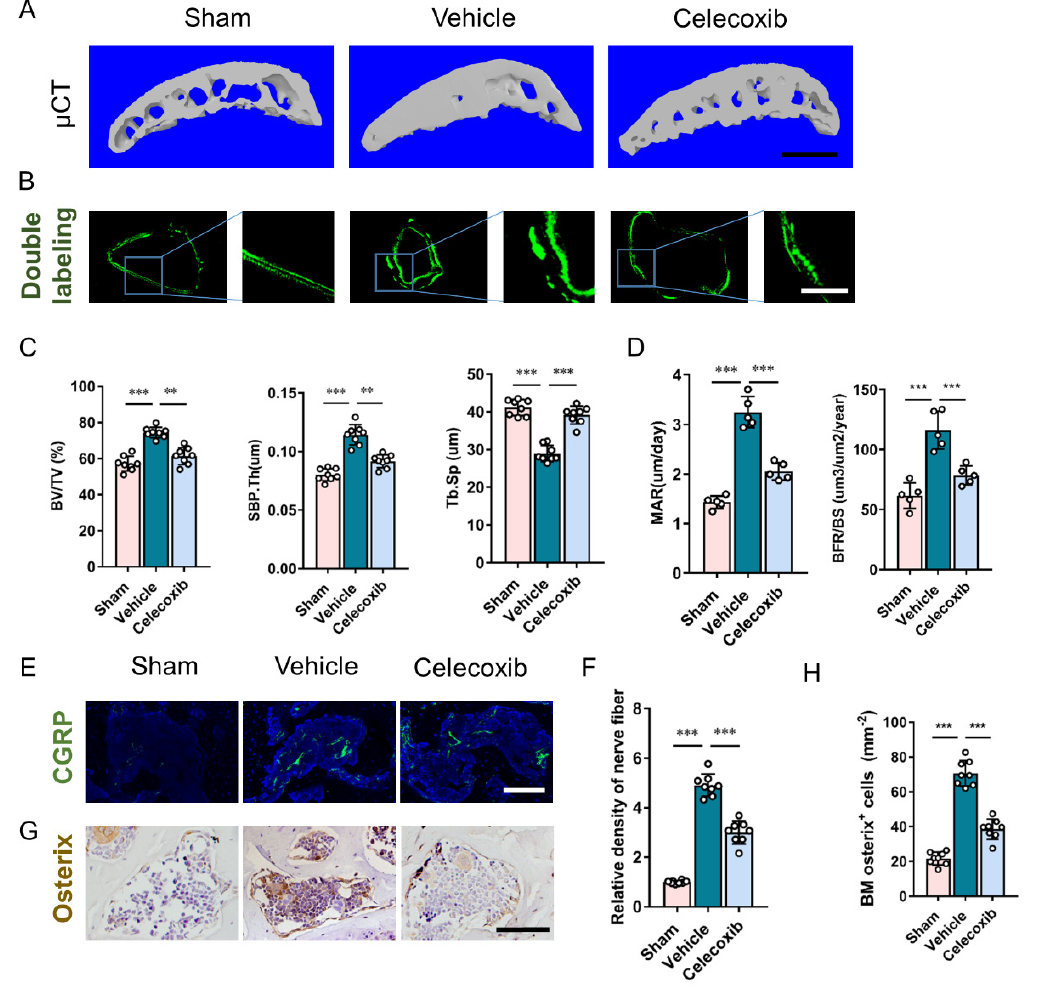
Figure 4. Inhibition of COX-2 attenuates uneven subchondral bone remodeling. ( A ) Three-dimensional microcomputed tomography ( µ CT) images of the medial compartment of tibial subchondral bone (sagittal view). Scale bar: 500 µ m. ( B ) Representative images of subchondral bone with calcein double labeling at four weeks following surgery. Scale bar: 20 µ m. ( C ) Quantitative analysis